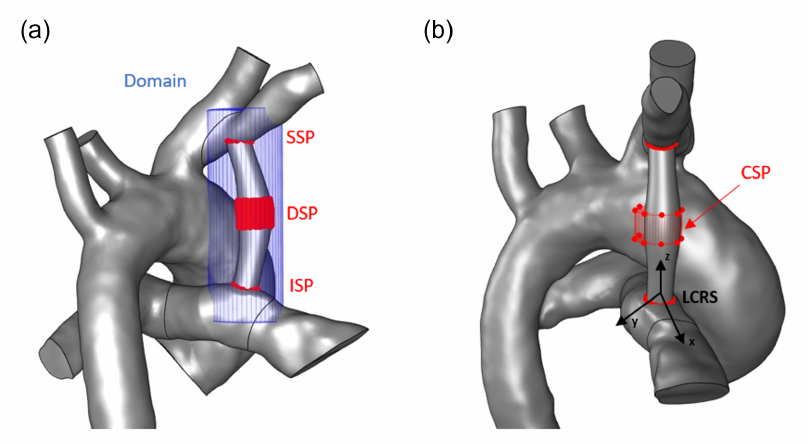
Figure 4. Location of the source points on the shunt’s geometry: SSP, DSP, and ISP sets with the cylindrical morphing domain ( a ) and CSP set with the LCRS system ( b